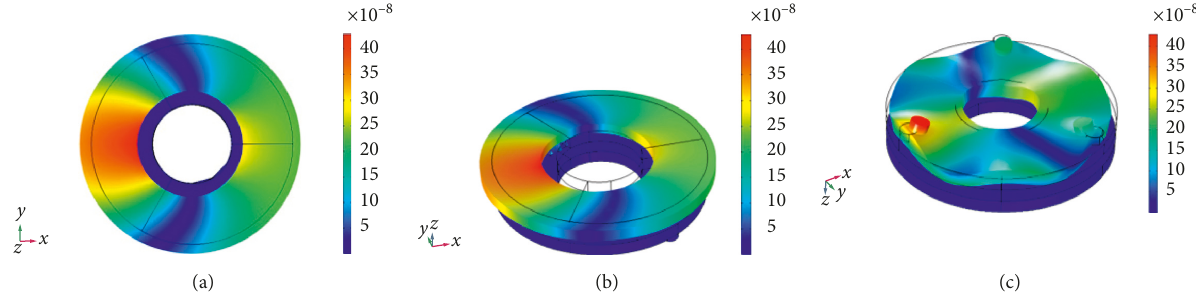
Figure 4: Vibration modes of the ring-type actuator when the upper ring is excited at 67.05kHz (a, b) and the lower ring is excited at 65.80kHz (c).